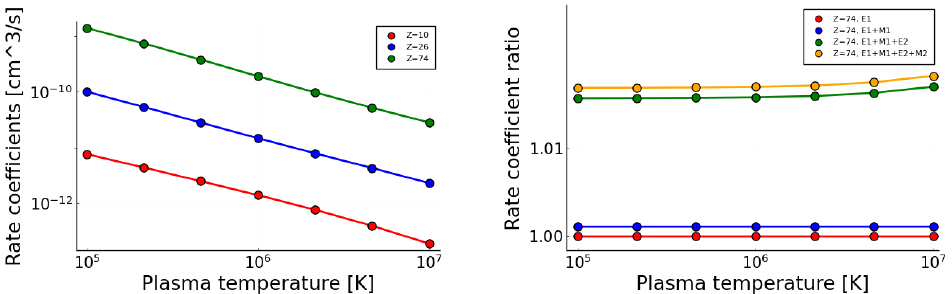
Figure 7. The same as in Fig. 4 but for the capture into selected helium-like ions. Left panel: RR plasma rate coefficients for Ne 8 + (red line), Fe 24 + (blue line), We 72 + (green line), and by applying the electric-dipole (E1) approximation. Right panel: Comparison of the ratio of total plasma rate coefficients, normalized on the E1 approximation, for W 72 + within the E1 (red line), E1+M1 (blue line), E1+M1+E2 (green line) and the E1+M1+E2+M2 approximation (orange line),